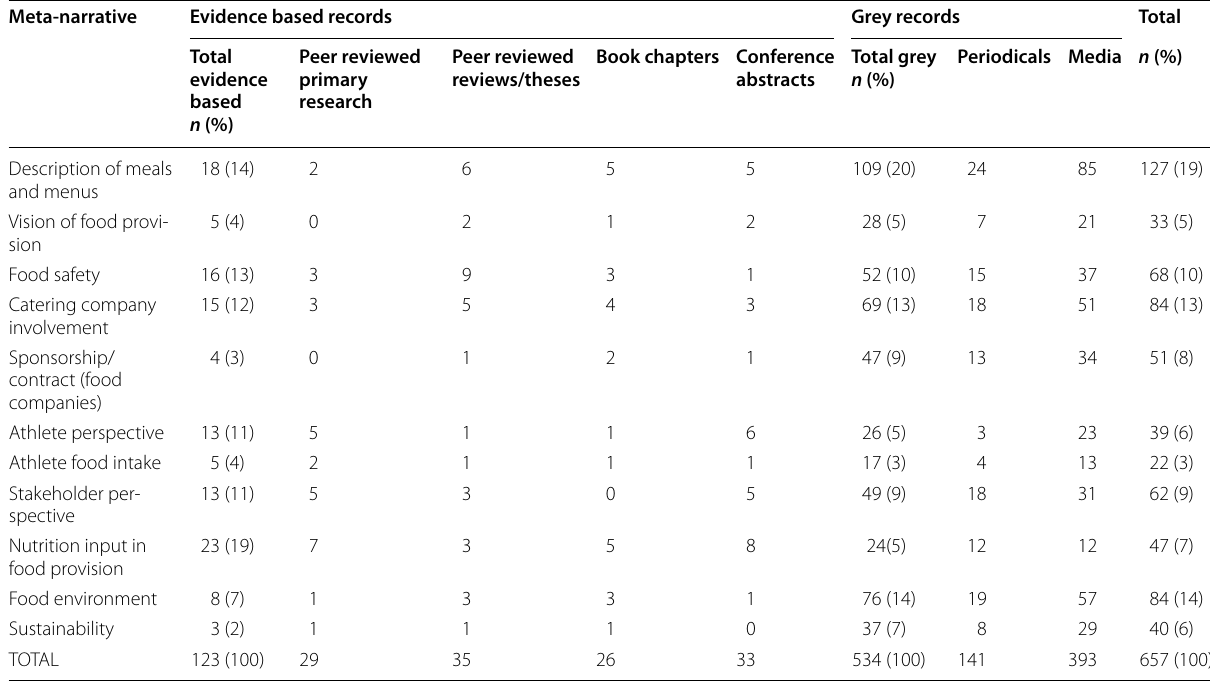
Table 2 Record type per meta narrative